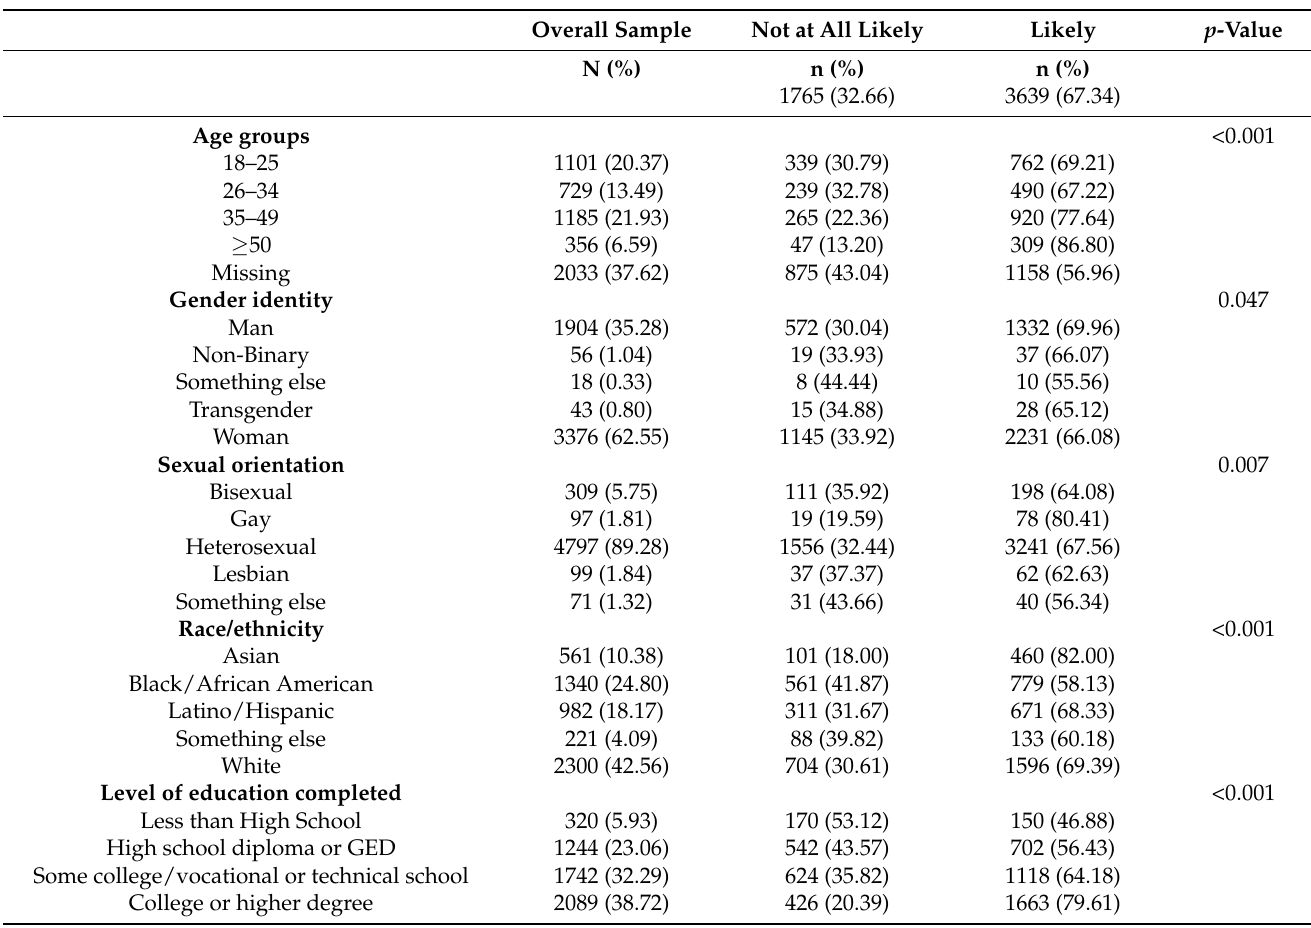
Table 1. Descriptive and bivariate analyses of the likelihood of getting vaccinated according to sociodemographic status, likelihood of contracting COVID-19, and mental health disorder symptoms (N = 5404). Overall Sample Not at All Likely